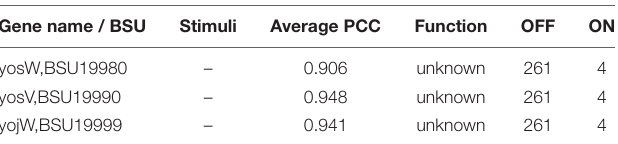
TABLE 8 | Atomic Regulon